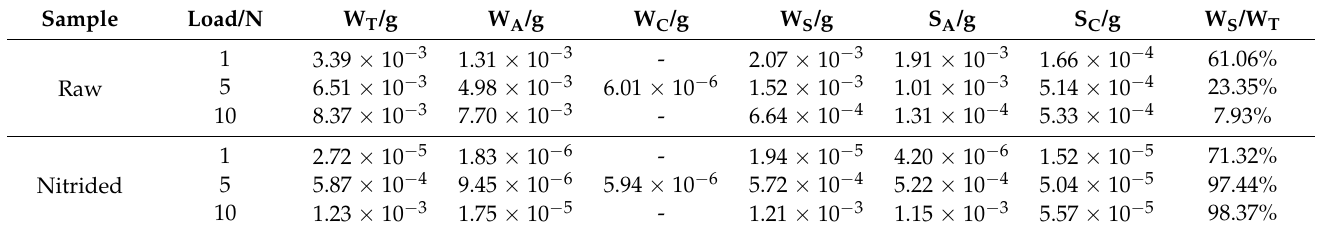
Figure 11. Material loss of the raw and nitrided samples subjected to tribocorrosion at anodic potential (E = 1.0 V) under different loads. Table 4. Material loss components of tribocorrosion of the raw and nitride samples at anodic potential (E = 1.0 V) under different loads.